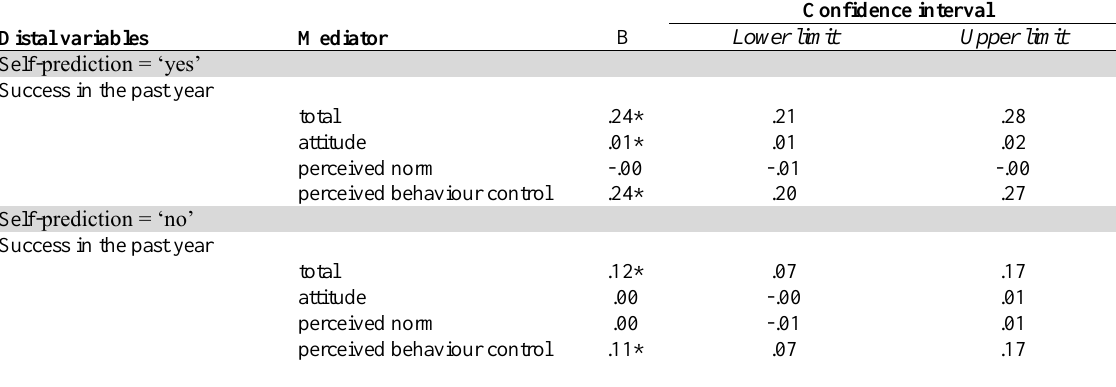
Tests for Determining the Significance of the Indirect Effects of the Independent Variable Success. B Indicates the Strength of the (Unstandardized) Indirect Effect Confidence interval Distal variables Mediator B Lower limit Upper limit Self-prediction = ‘yes’ Success in the past year total .24* .21 .28 attitude .01* .01 .02 perceived norm -.00 -.01 -.00 perceived behaviour control .24* .20 .27 Self-prediction = ‘no’ Success in the past year total .12* .07 .17 attitude .00 -.00 .01 perceived norm .00 -.01 .01 perceived behaviour control .11* .07